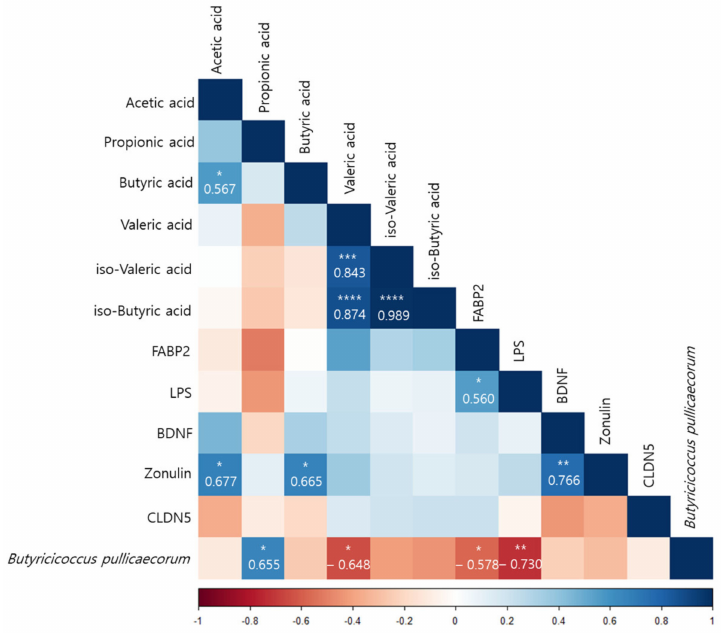
Figure 7. Pearson correlation analysis presenting the correlation between Butyricicoccus pullicaecorum and the plasma concentrations and the amount of fecal SCFAs before and after intervention in the flavonoid-rich orange juice group. After 8 weeks of orange juice intervention, Butyricicoccus pullicaecorum significantly negatively correlated with the blood markers of human FABP2, LPS, and valeric acid and was significantly positively correlated with the amount of propionic acid. * p < 0.05; ** p < 0.01; *** p < 0.001; **** p <